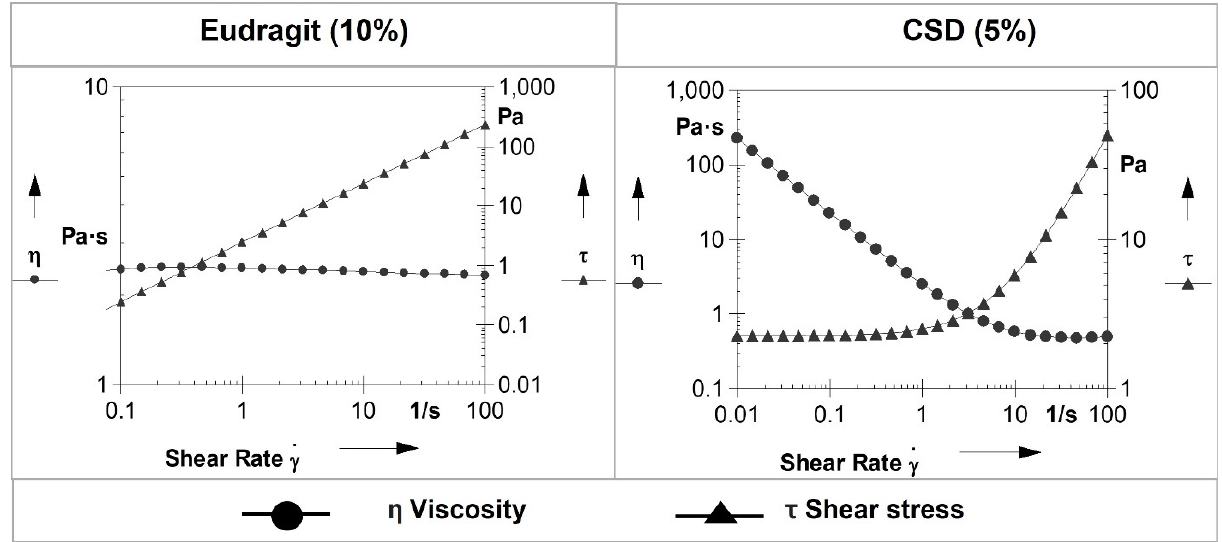
Figure 4. Rheological characterizations of gels: flow curves of Eudragit (10%) and CSD (5%) gels.